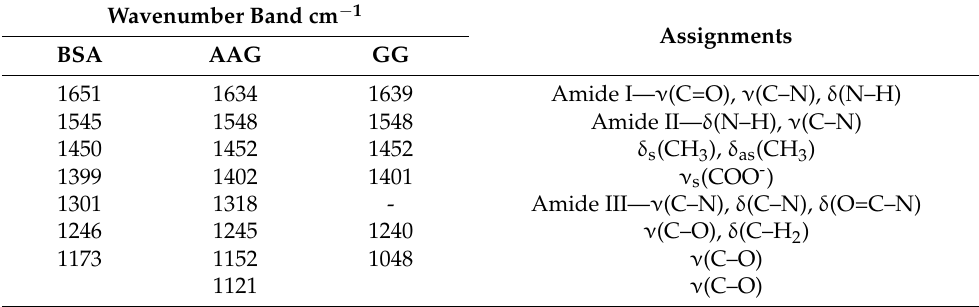
Figure 5. The ATR-IR spectra of fingerprint range for BSA (black line), AAG (blue line), and GG (green line). Table 5. The characteristic absorption band was detected in ATR-IR spectra of